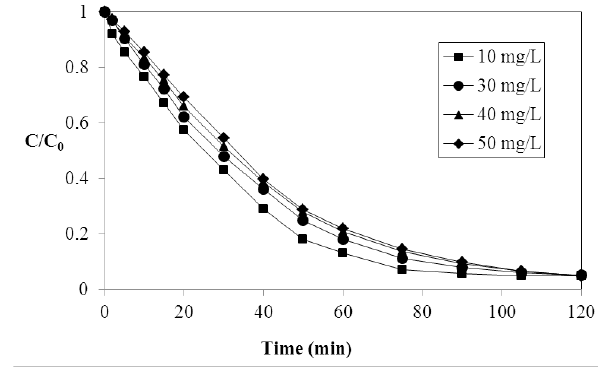
Figure 2: Kinetics of AB25 decolorization (absorption at 602 nm) by glow discharge in Ar atmosphere for different initial dye concentrations (treated volume 500 mL; initial dye concentration in the range of 10 –50 mg L -1 ; pH of 6.7).